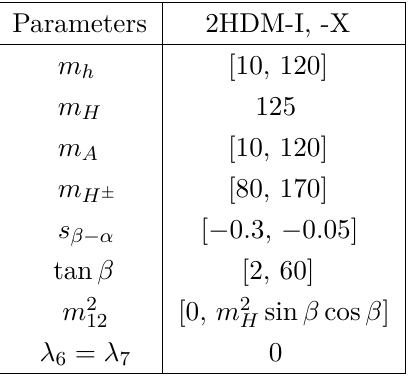
Table 2 . 2HDM Type-I and -X parameter scans adopted (all masses are in